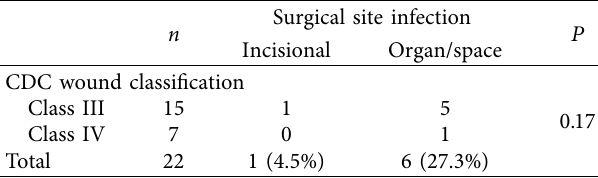
Table 4: Te length of postoperative hospital stay according to the wound status.